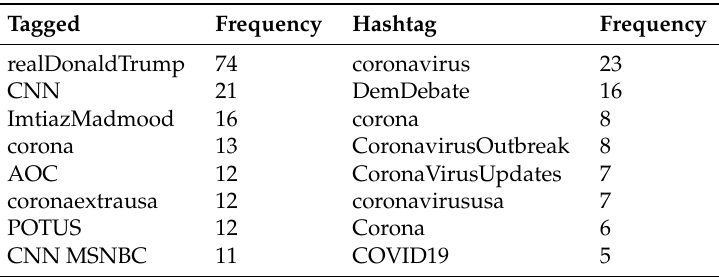
Table 2. Summary of endogenous